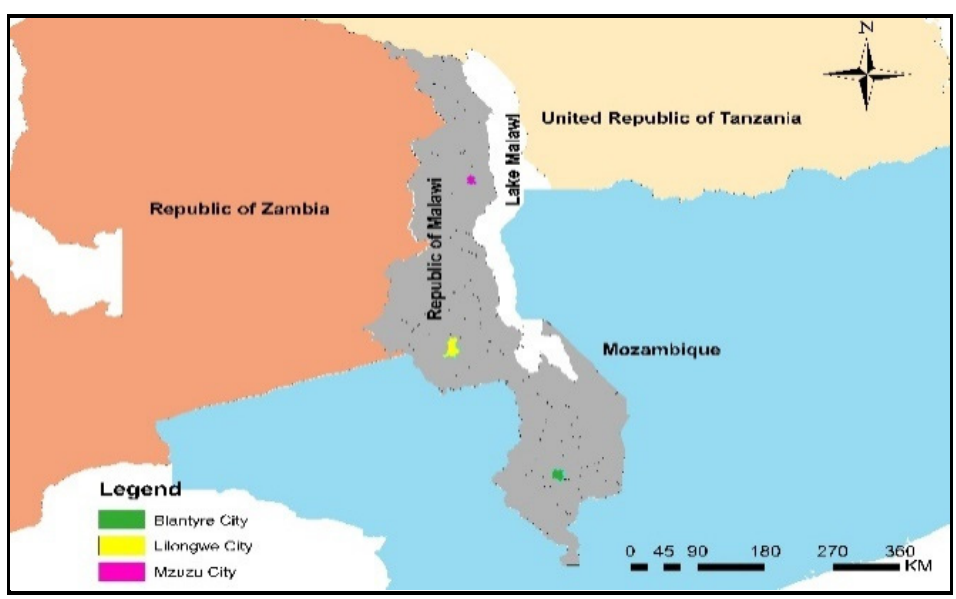
Figure 2. The locations of the three